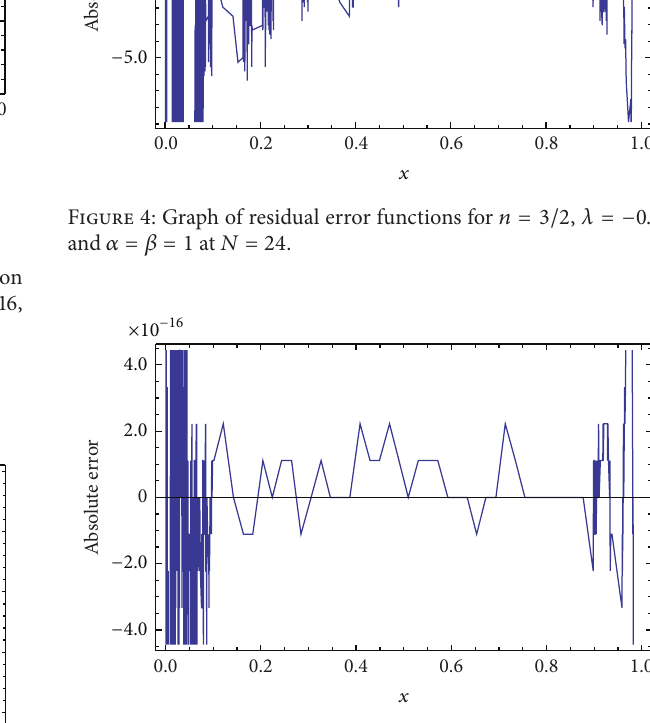
Figure 5: Graph of residual error functions for 𝑛 = 3/2 , 𝜆 = 0.5 , and 𝛼 = 𝛽 = 1 at 𝑁 = 24